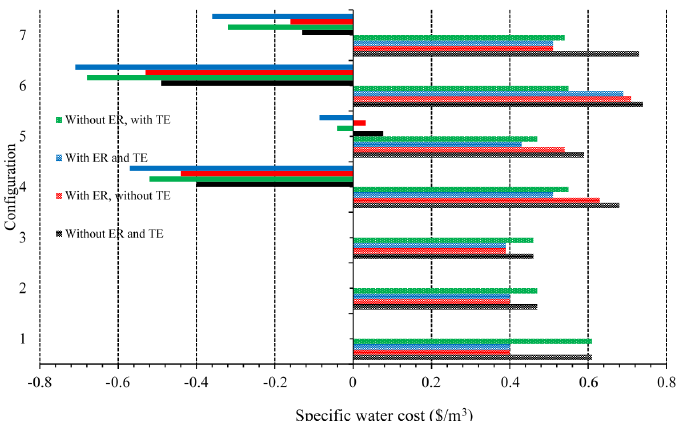
Figure 3. Specific water cost of different integrated configurations without considering sale of salt (patterned bars) and after considering sale of salt (solid lines). ER: Mechanical energy recovery; TE: Thermal energy recovery; MF, Microfiltration; NF, Nanofiltration; MD, membrane distillation; 1 = Configuration 1: RO alone; 2 = Configuration 2: NF ‐ RO; 3 = Configuration 3: MF ‐ NF ‐ RO; 4 = Configuration 4: MF ‐ NF( ‐ MCr) ‐ RO; 5 = Configuration 5: MF ‐ NF ‐ RO( ‐ MCr); 6 = Configuration 6: MF ‐ NF( ‐ MCr) ‐ RO( ‐ MD); 7 = Configuration 7: MF ‐ NF( ‐ MCr) ‐ RO( ‐ MCr).